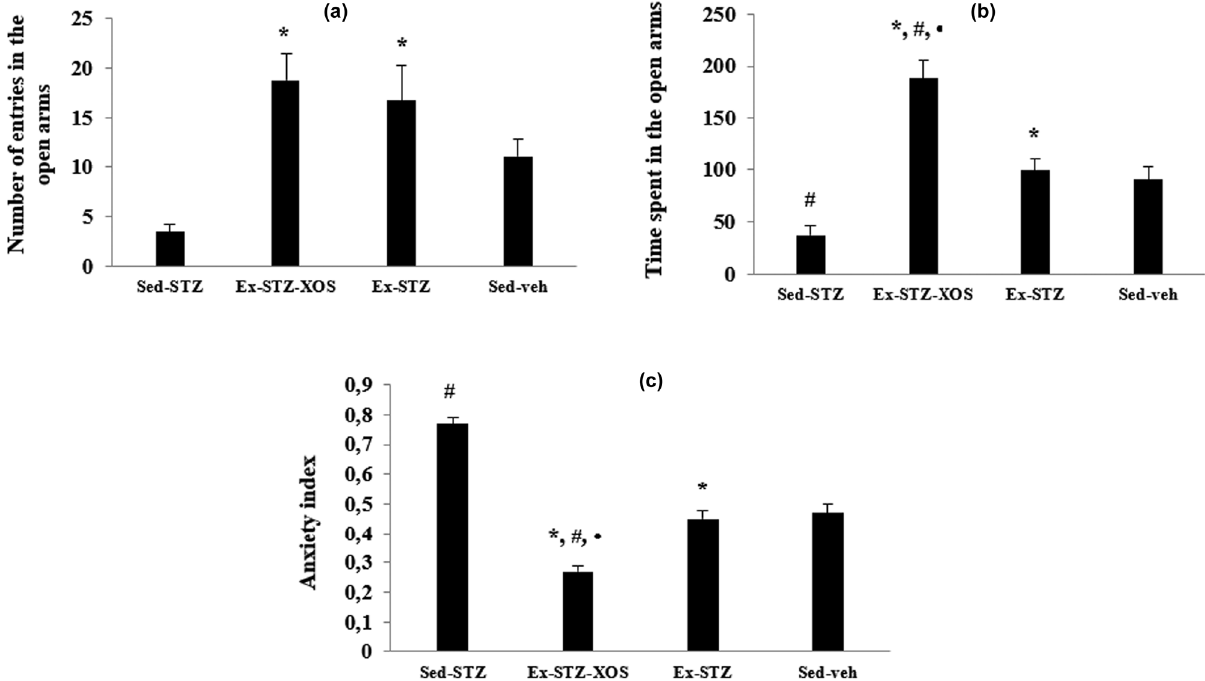
Figure 4: E ff ect of XOS and/or the aerobic training on the results from the elevated plus maze test. ( a ) Number of entries in the open arms; ( b ) Time spent in the open arms; ( c ) Anxiety index. * Signi fi cant di ff erences in comparison to Sed - STZ; # signi fi cant di ff erences in comparison to Sed - veh; and (cid:129) signi fi cant di ff erences in comparison to Ex -